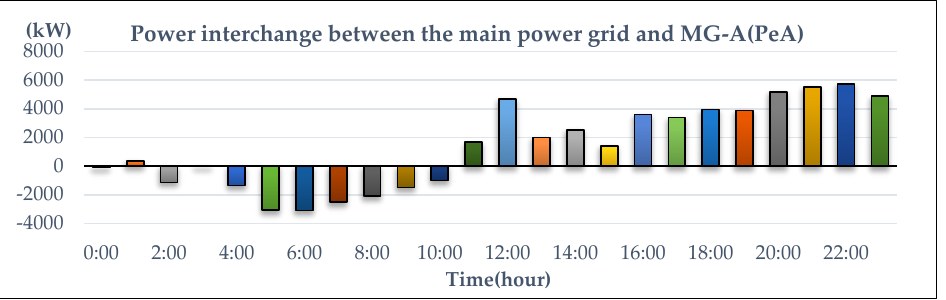
Figure 10. Power interchange between the main power grid and MG-A.